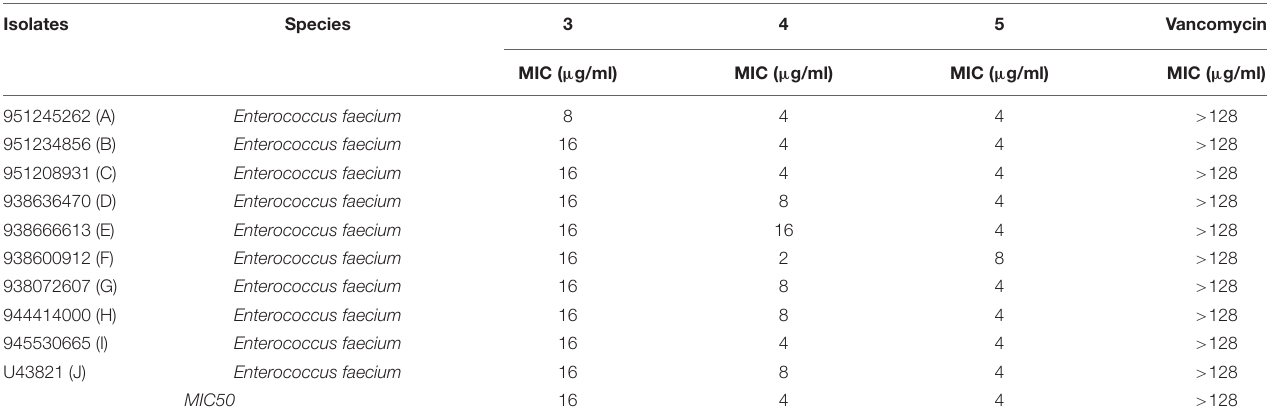
TABLE 3 | Minimum inhibitory concentration of Teixobactin derivatives against vancomycin-resistant enterococci (VRE).